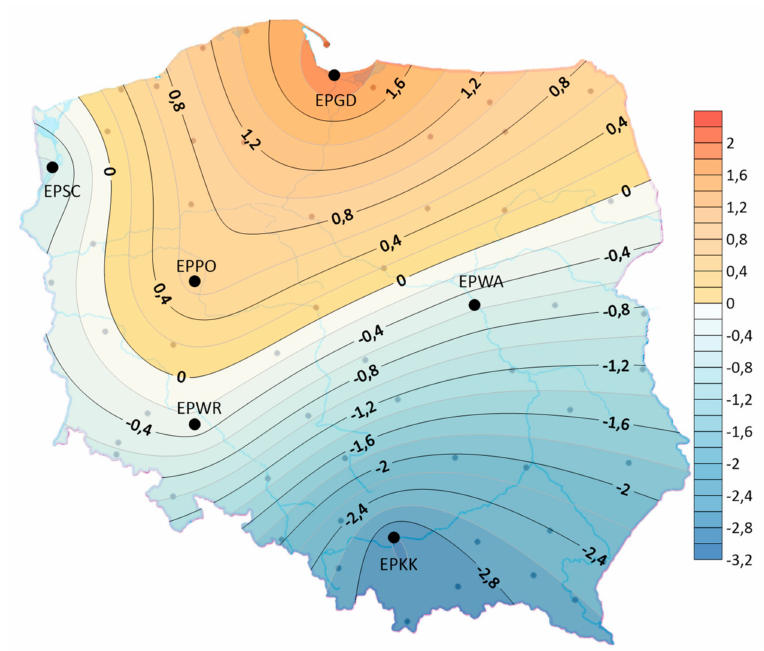
Figure 7. The distribution of the linear trend indicator of the average annual duration of the storm (hours / 10 years),